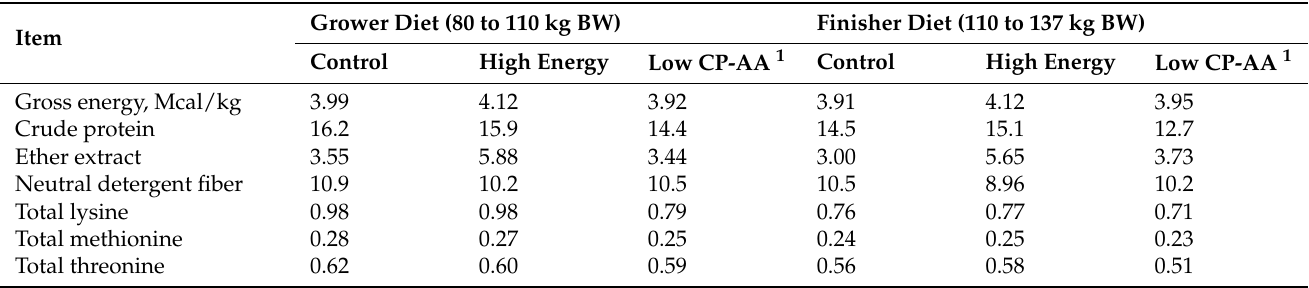
Table 1. Analyzed nutrient composition of the experimental diets (%, as-fed